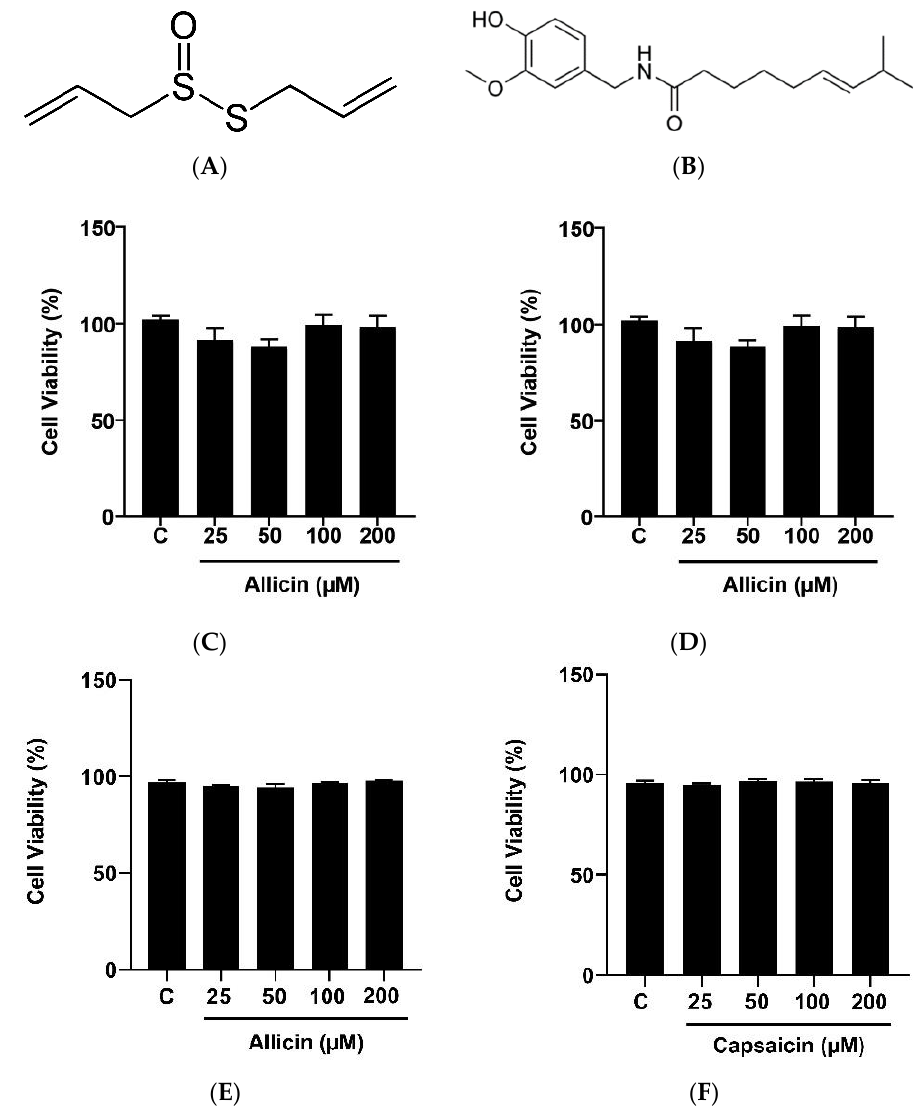
Figure 1. Effects of allicin and capsaicin on HepG2 cell viability. Chemical structure of allicin ( A ). Chemical structure of capsaicin ( B ). HepG2 cells were cultured in starvation medium and treated with vehicle (0.1% DMSO) or allicin (0, 25, 50, 100, 200 μM) ( C , E ) and capsaicin (0, 25, 50, 100, 200 μM) ( D , F ) for 24 h. Cell viability was measured using the MTT assay ( C , D ) and the trypan blue exclusion assay ( E , F ). The data represent the mean ± SD of three independent experiments ( N = 3).